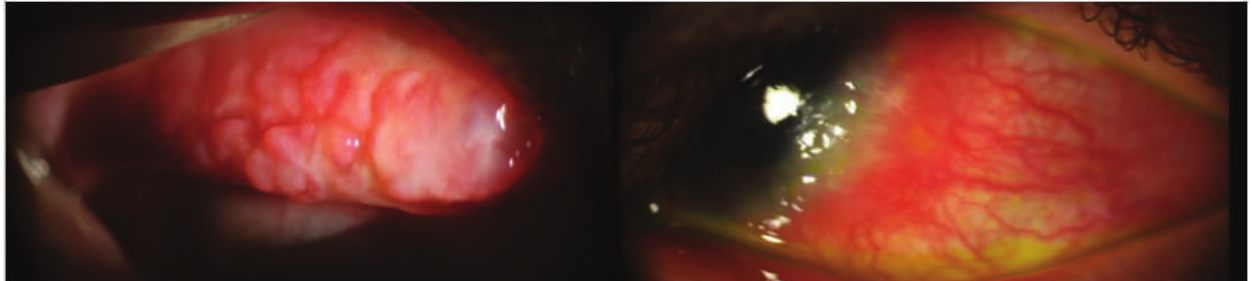
Figure 6. Cobblestone appearance of large conjunctival papillae in a patient with VKC (left). Limbal VKC with Horner-Trantas dots in another patient